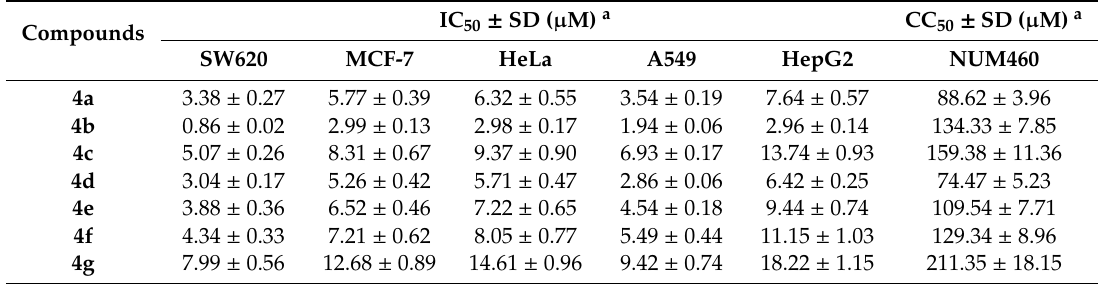
Table 4. In vitro antiproliferation inhibitory activities of compounds 4a – 4z and Celecoxib.